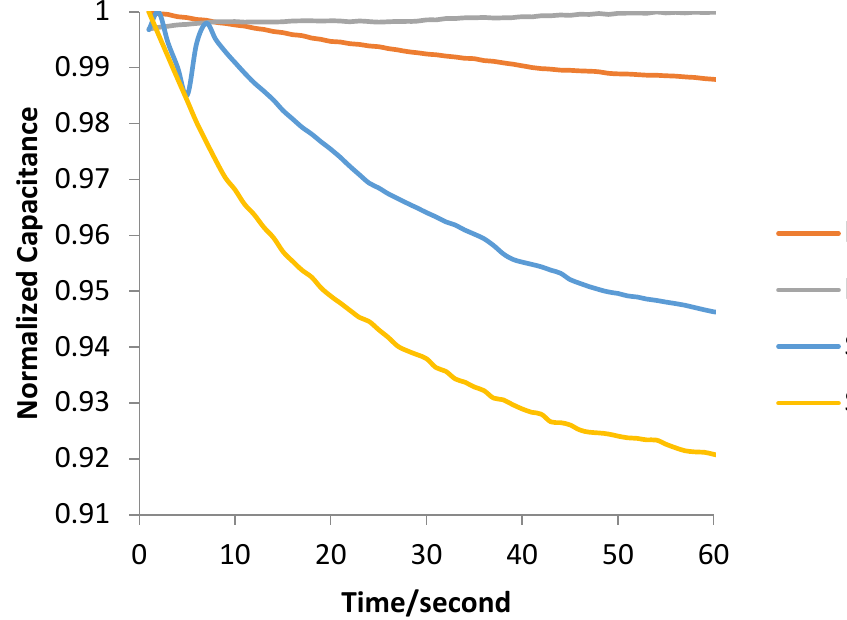
0.910.92 Figure 6. Normalized capacitance change over time for S Figure 6. Normalized capacitance change over time for S protein.